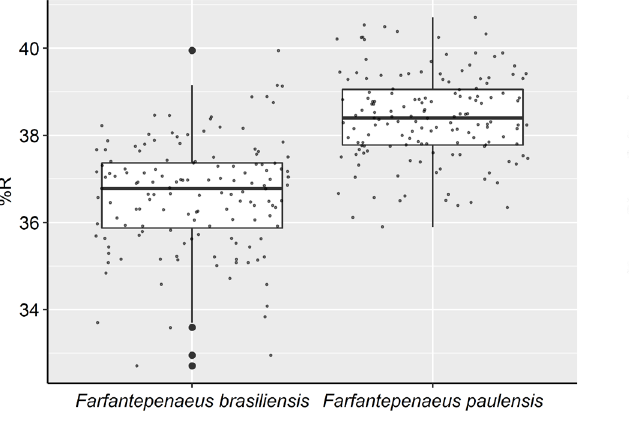
Figure 5. Box plot of percentage of rostral length (mm) in relation to cephalothorax length (mm) (%RL) for Farfantepenaeus brasi- liensis and F. paulensis caught in the Rocha lagoon in April 2019.